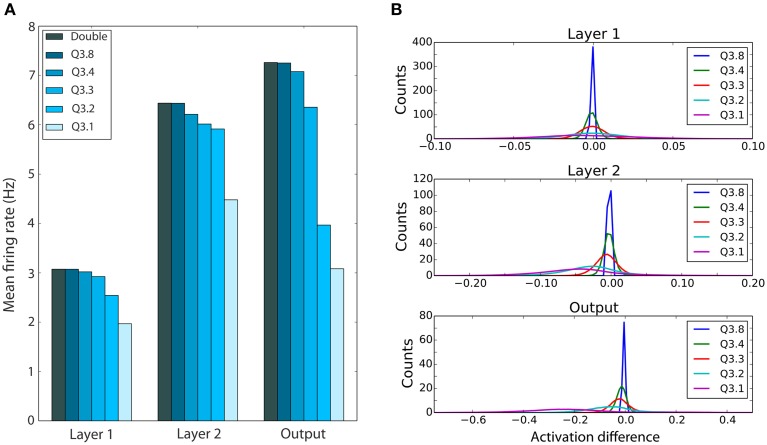
Effect of reduced bit precision on firing rates in the DBN and neuron activations. (A) Mean firing rate of each layer of the network for weights with different bit precisions, using an input rate of 1500 Hz. Lower precision levels, which lead to more weights at zero, cause lower firing rates within the network. (B) Distribution of the mean difference between the activation of a neuron with double precision weights and neurons using weights with different bit precision levels. Shown are distributions over all test samples. The difference, although peaked near zero, increases for higher layers, and shows a trend toward reduced activations.